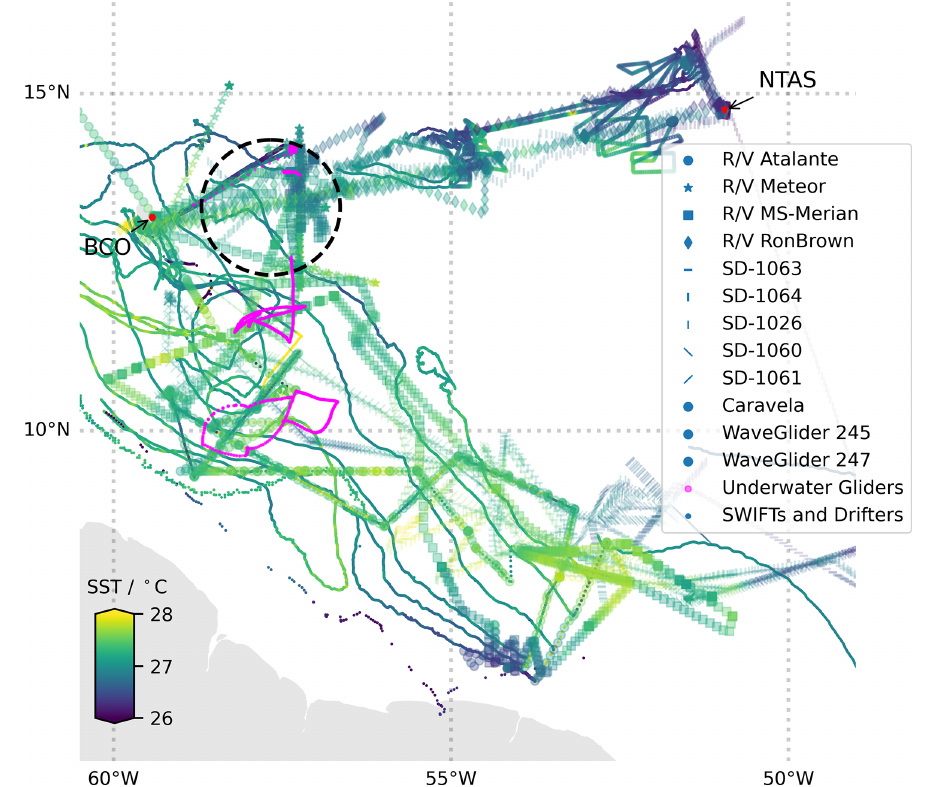
Figure 4. Map showing surface- and subsurface-platform trajectories, colored by (uncalibrated) near-surface water temperature for platforms with near-surface